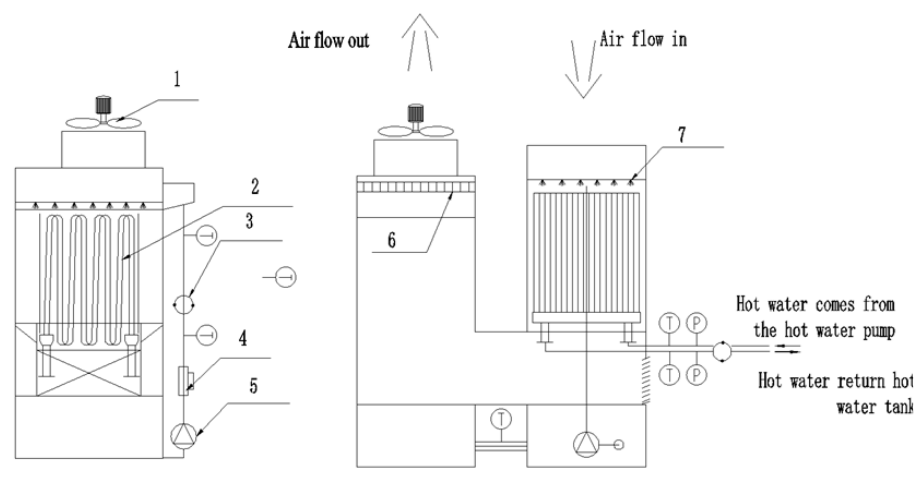
Figure 2. Schematic diagram of the vertical CECT: 1—induced draft fan; 2—heat exchanger coil; 3—electromagnetic flowmeter; 4—electronic fouling remover; 5—circulating spray pump; 6—drift eliminator; 7—spray device.